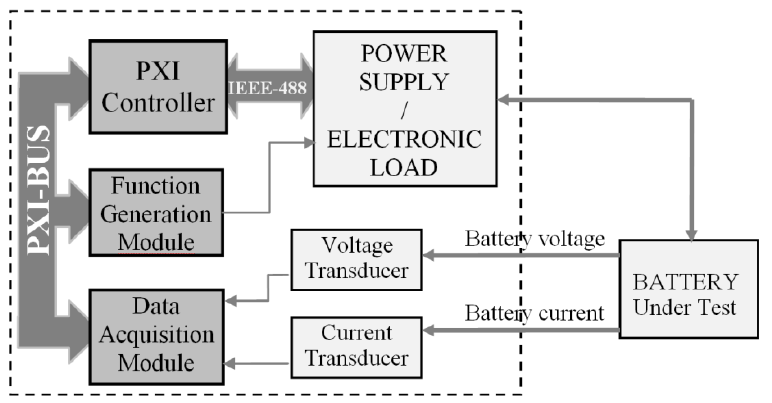
Figure 3. Block scheme of the realized Automated Measurement